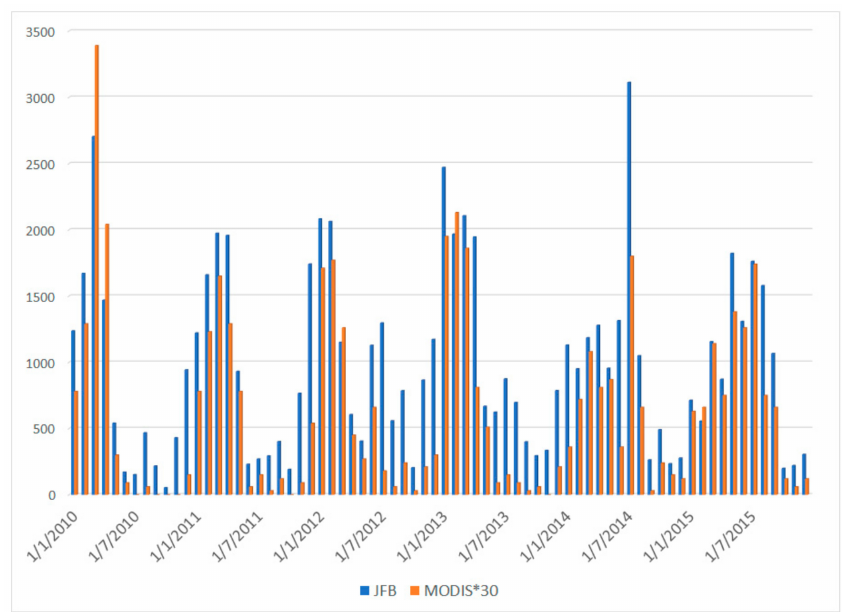
Figure 2. Monthly variations in Jamaica fire frequency data for 2001–2015. The JFB data (blue) and the MODIS data (orange) are shown. The MODIS data is multiplied by a factor of 30 for comparison with the JFB.